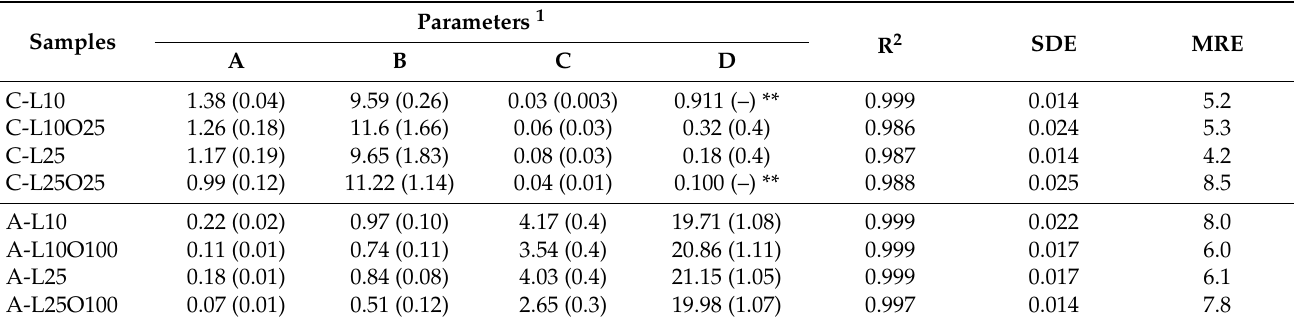
Table 2. Peleg model parameters. 1 Values are expressed as mean ( ± standard deviation). ** × 10 − 14 ; R 2 : Coefficient of determination; SDE: Standard deviation of the estimate; MRE: Mean relative error. Samples